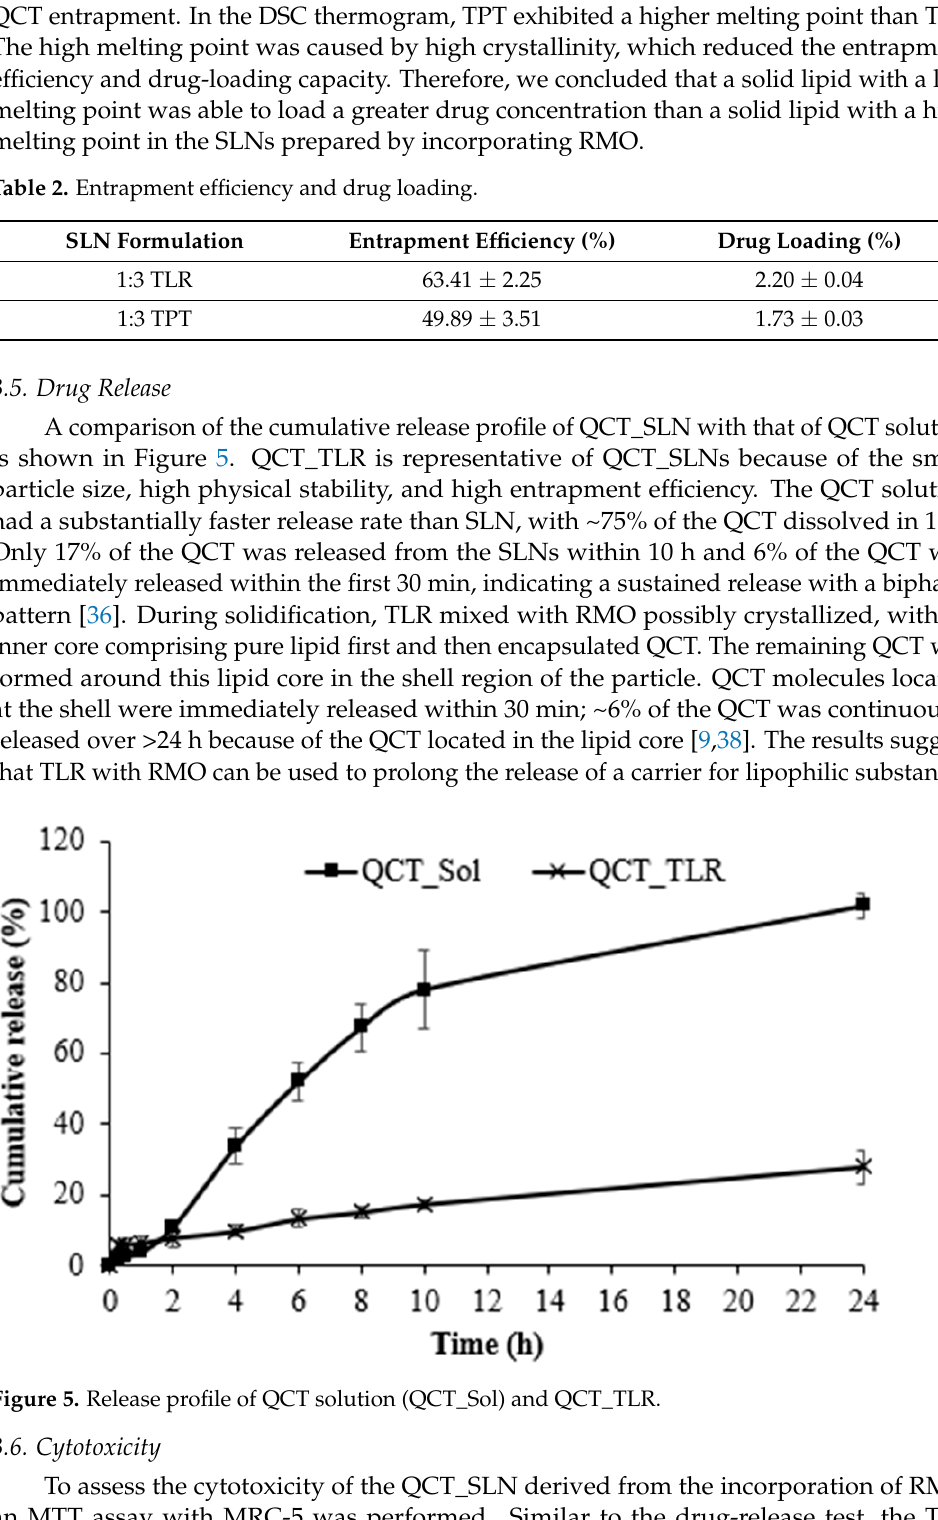
Table 2. Entrapment efficiency and drug loading.